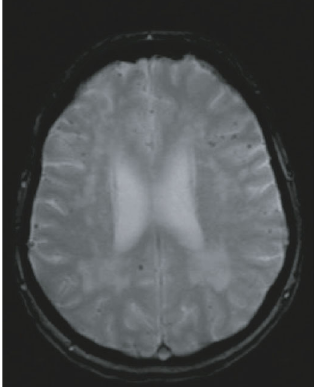
Figure 1: MRI (Gradient echo). 67F, presented with cognitive de fi cits which were fi rst noticed by close relatives six years prior and initially thought to be due to severe depression. MMSE 18/30, ACER 58/100. MRI demonstrated extensive cerebral amyloid